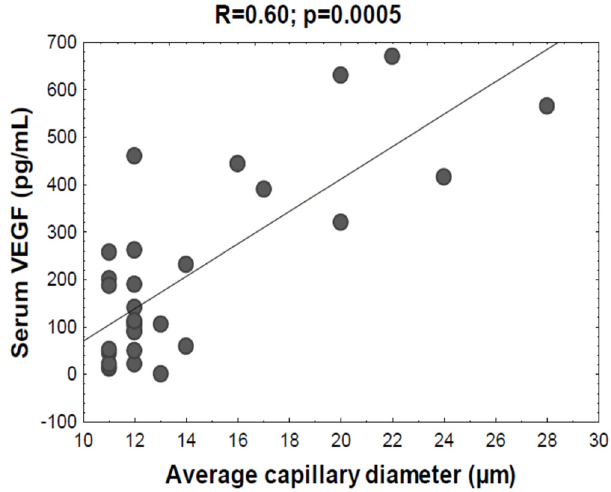
Figure 3. Correlation between serum VEGF levels and average capillary diameter.